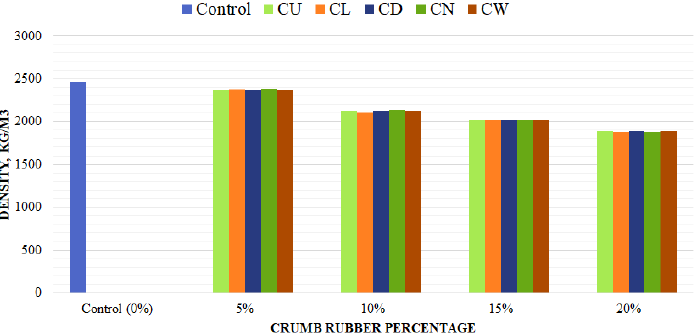
Figure 5. Density of concrete at 7 days.